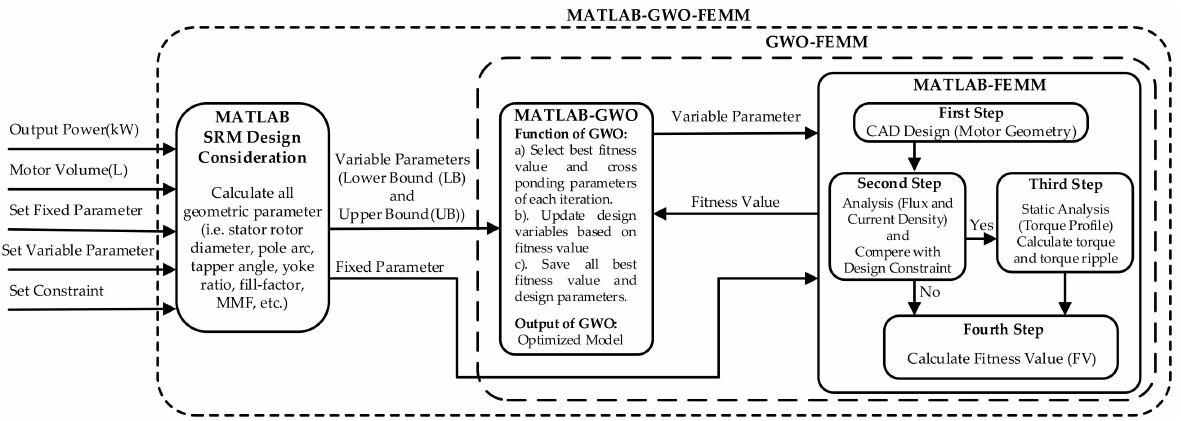
Figure 7. Modeling of GWO-FEMM (Finite Element Method Magnetics).